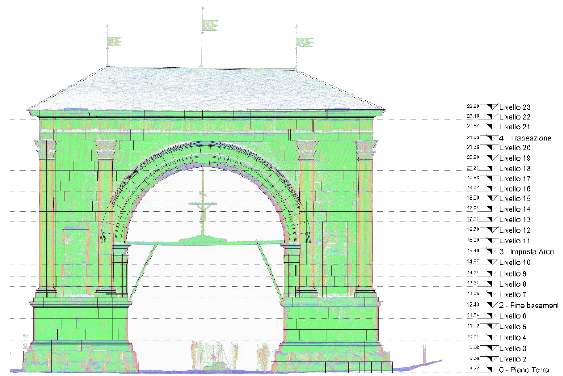
Figure 4: West elevation with the point cloud normal visualization and the